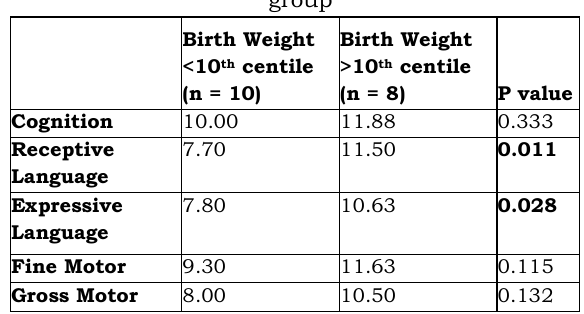
Table 4: Comparison of mean neurodevelopmental score among small-for-gestation-age infants and appropriate-for-age infants among the gastroschisis